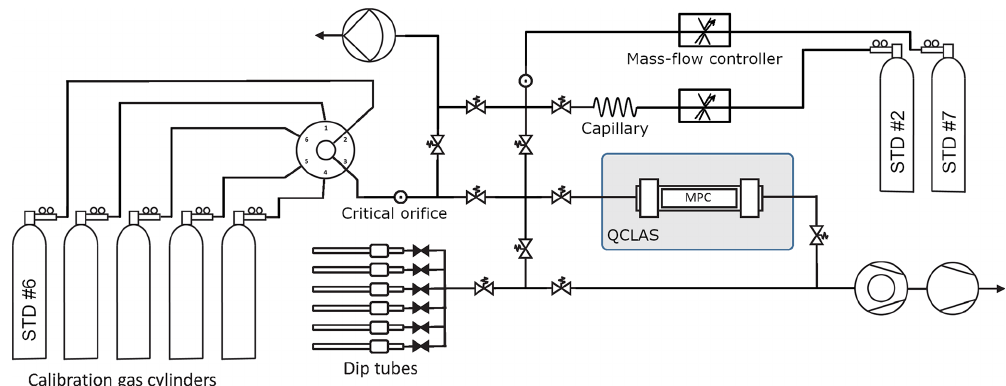
Figure 6. Gas handling system used to introduce the small air samples from dip tubes into the QCLAS. The entire system is made of ultra-high-vacuum (UHV) stainless-steel tubing and uses exclusively VCR seals in the low-pressure part downstream of the flow restrictions (critical orifices and fused silica capillary) up to the multi-pass cell. The valves are pneumatically actuated, full-metal valves (Fujikin Inc., Japan).